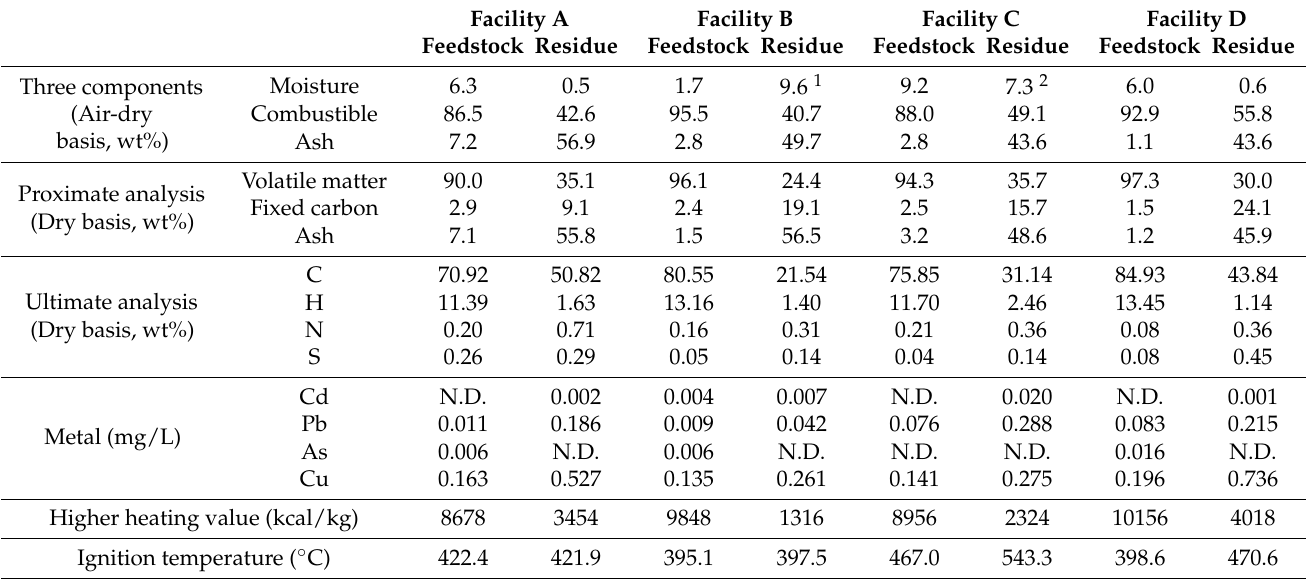
Table 2. Physical and chemical properties of pyrolysis feedstock and